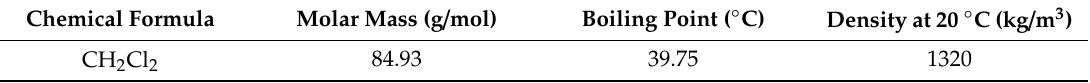
Table 2. Characteristics of Dichloromethane used as a chemical